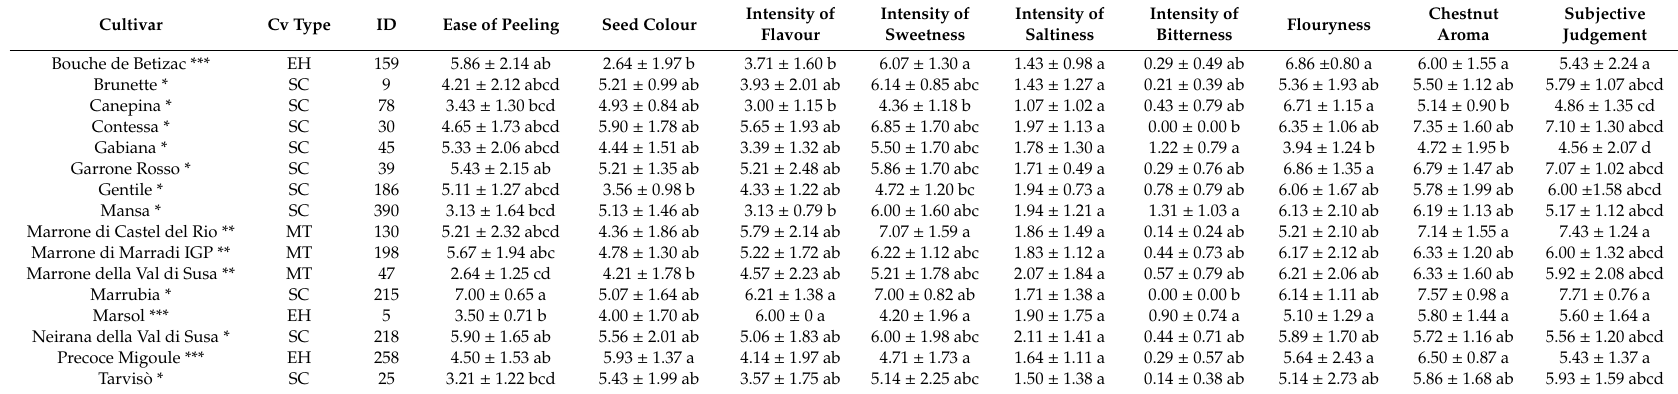
Table 3. Sensory profiles of the analysed